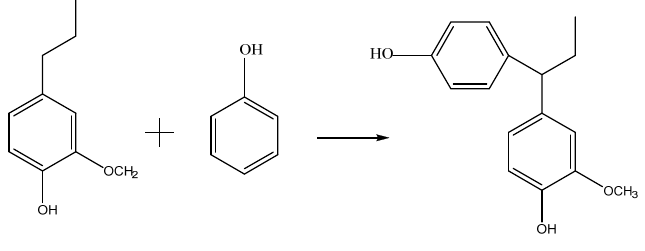
Figure 1. Reaction of lignin phenolation.